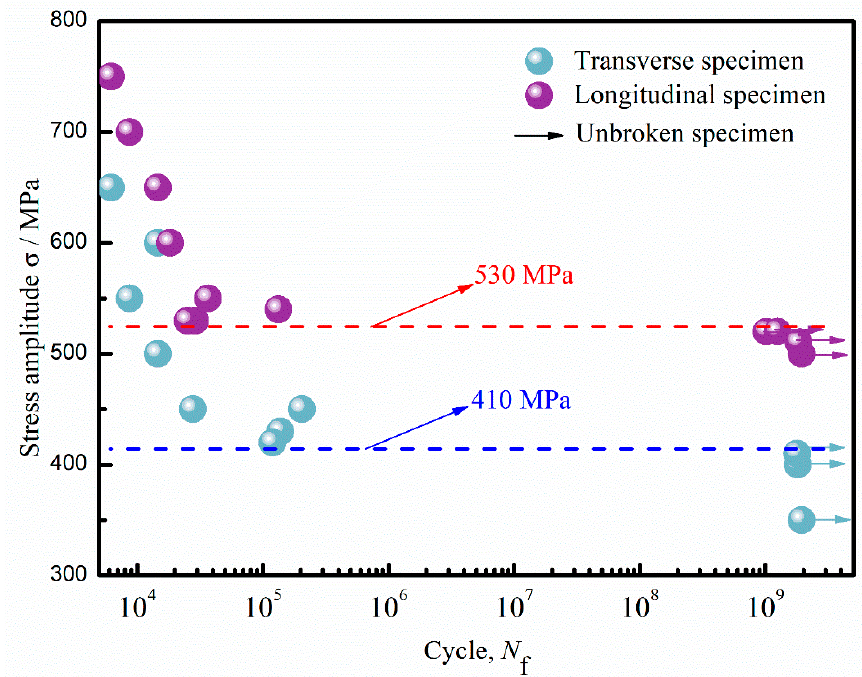
Figure 10. S-N curve of the internal crack initiation.